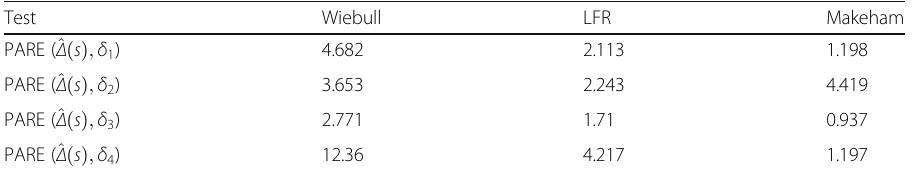
Table 1 The asymptotic relative efficiencies for our test versus δ i , i = 1, 2, 3, 4 Test Wiebull LFR Makeham PARE ( ^ Δ ð s Þ ; δ 1 ) 4.682 2.113 1.198 3.653 PARE ( ^ Δ ð s Þ ; δ 4